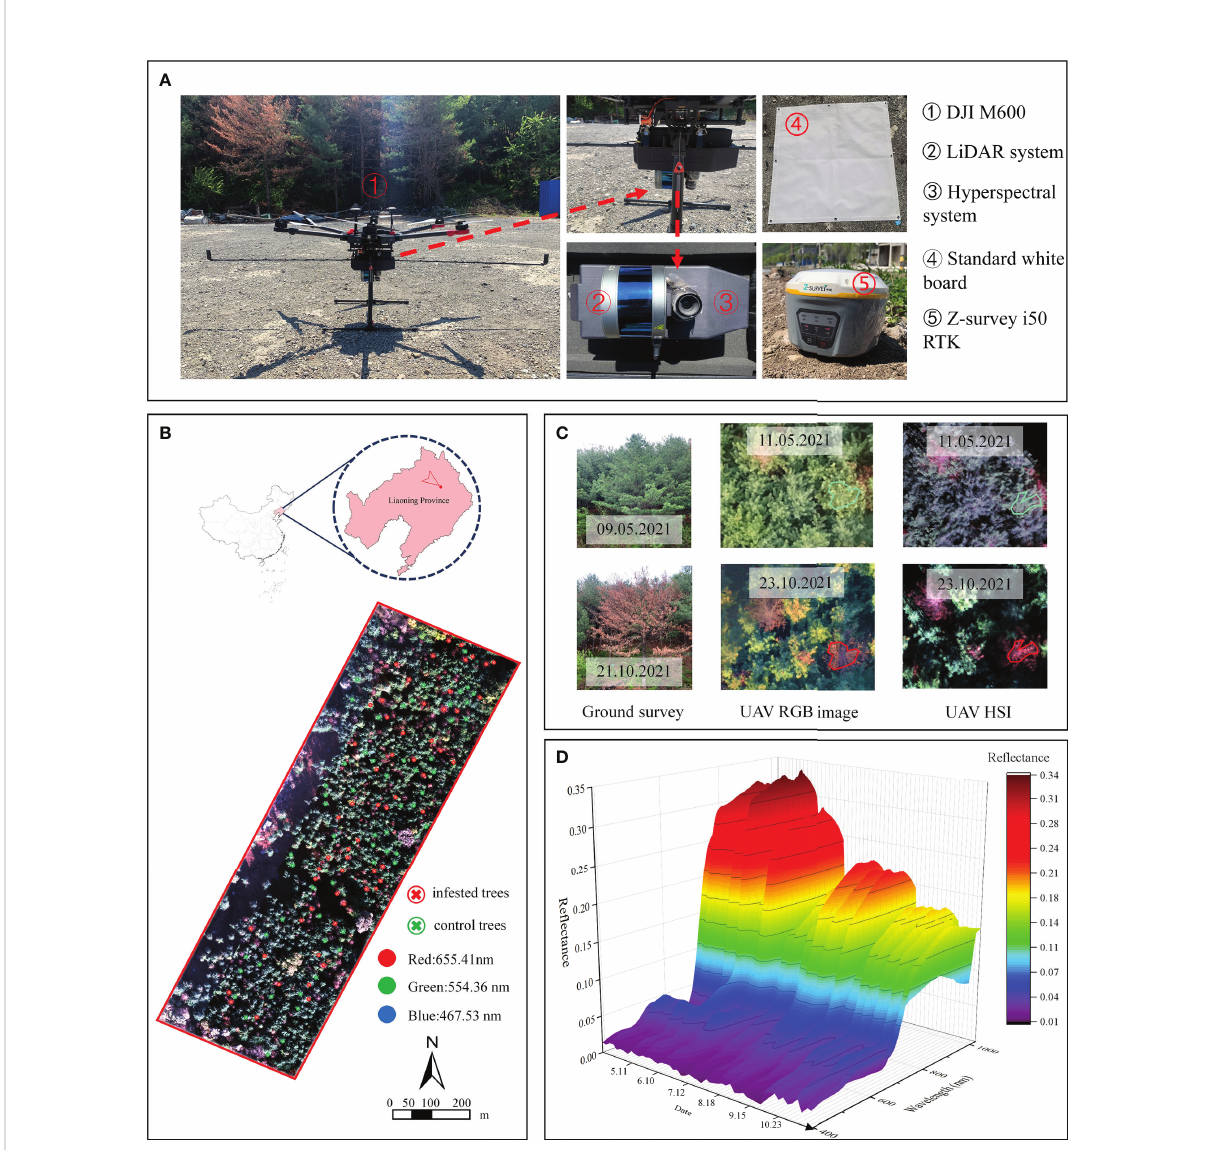
FIGURE 3 The UAV-based hyperspectral and LiDAR system (A) and location of the study area and the hyperspectral image of the test site acquired on 23 October (B) . An example pine tree shows the process of discoloration in the fi eld, UAV RGB and hyperspectral images (C) and examples of hyperspectral curves of sample trees at different dates (D) .